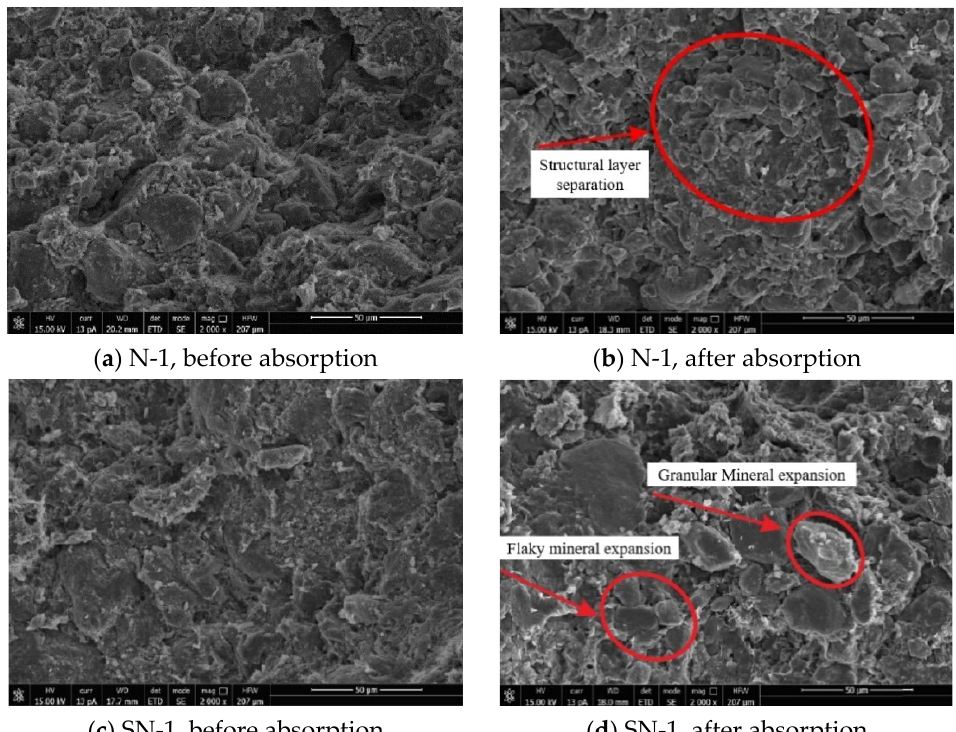
Figure 2. SEM of mudstone before and after water absorption at low magnification.